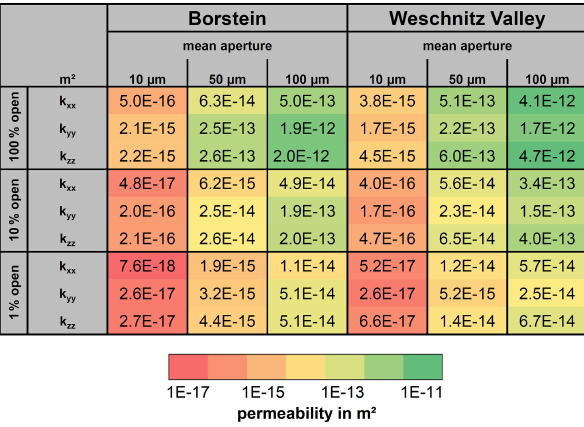
Figure 8. Summary of the DFN modeling. The Oda permeabilities in the x , y and z directions were calculated as a function of the frac- ture density, orientation, aperture and proportion of open